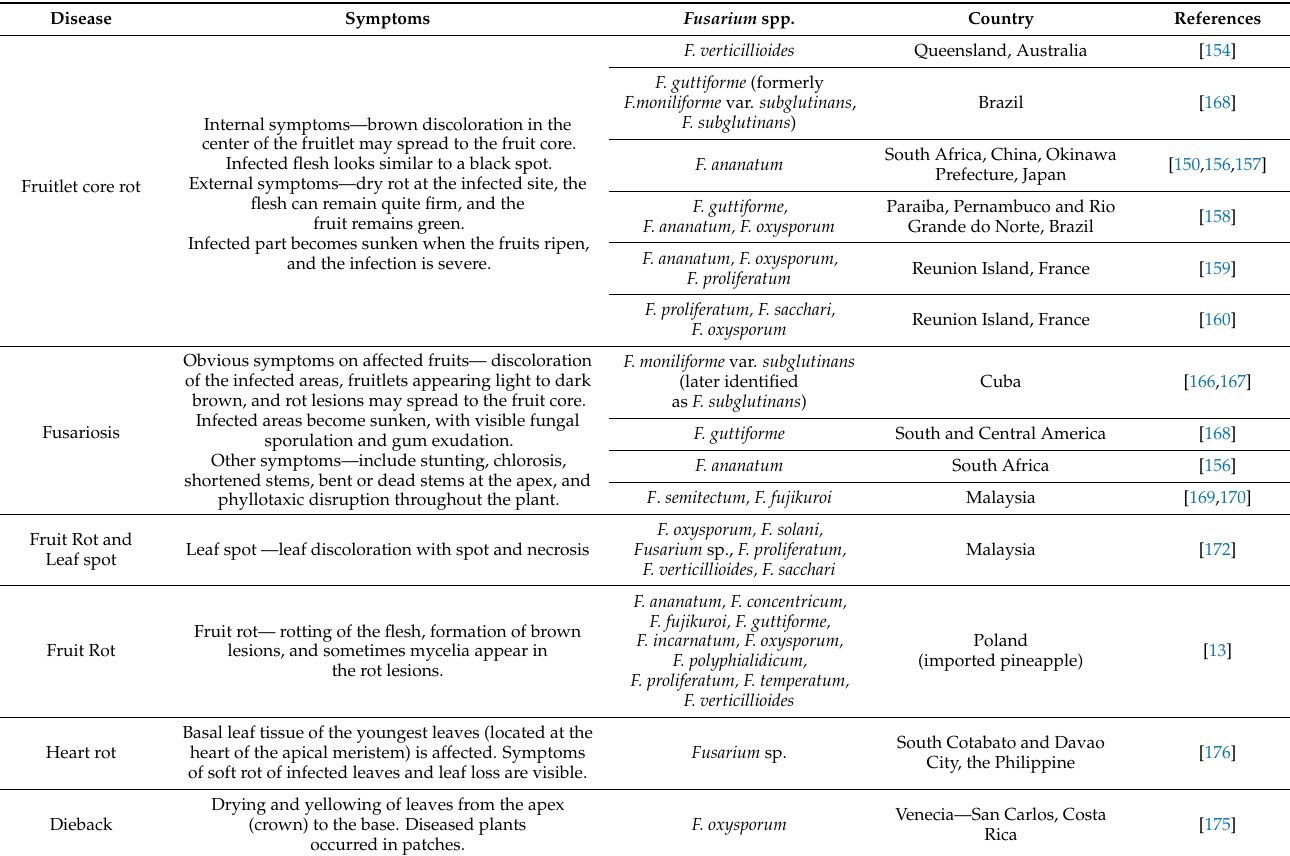
Table 4. Fusarium spp. associated with pineapple